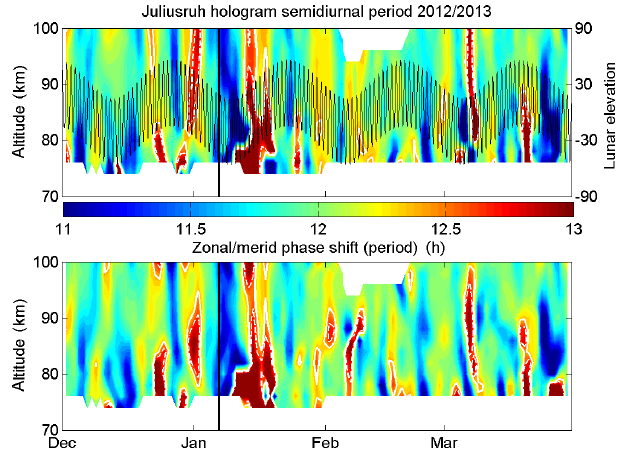
Figure 12. Holographic reconstruction of the semidiurnal tidal phase variability. The hologram shows the periods using a time- variable phase, which is equivalent to a frequency shift or change in period. The white contour lines indicate the lunar tides M2 (12.42h) (solid line) and N2 (12.66h) (dashed line). The lunar orbit as ele- vation angle ( − 90 to 90 ◦ ) for Juliusruh is plotted as a solid black line.